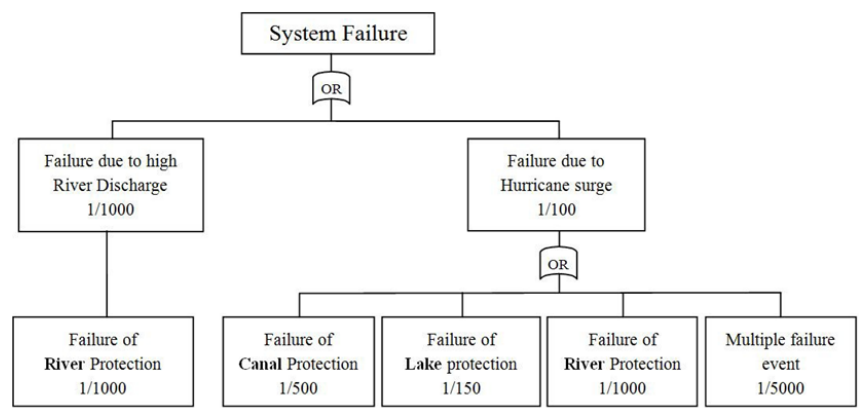
Figure 5. Fault tree depicting the various ways the protection system for the New Orleans metro bowl can fail. The probabilities for the various scenarios are indicated as frequencies per